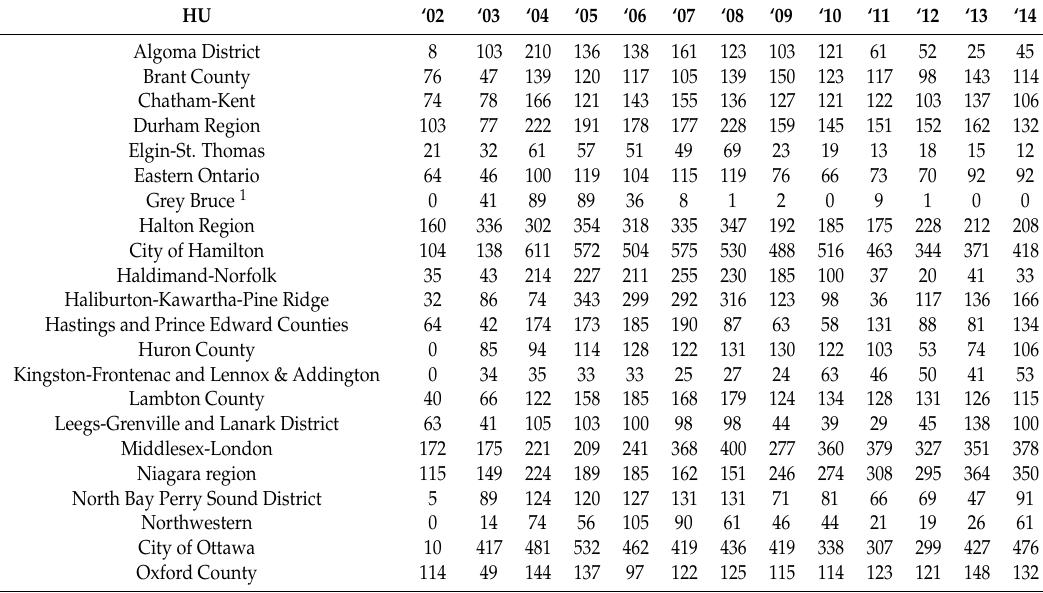
Figure A2. Ordination plots of the first 2 principal components. ( a ) Ae. japonicus ; ( b ) Ae. vexans ; ( c ) An. punctipennis ; ( d ) An. quadrimaculatus ; ( e ) An. walkeri ; ( f ) Cx. pipiens/restuans ; ( g ) Cx. salinarius ; ( h ) Cx. tarsalis ; ( i ) Och. canadensis ; ( j ) Och. stimulans ; ( k ) Och. triseriatus ; ( l ) Och. trivittatus . Abbreviations: DEM, digital elevation model; PARK, proximity to conservation areas and provincial parks; PC, principal component; POP; proximity to population centres; WET, proximity to wetlands; var., variance. Table A1. Total number of trapping nights in each HU by